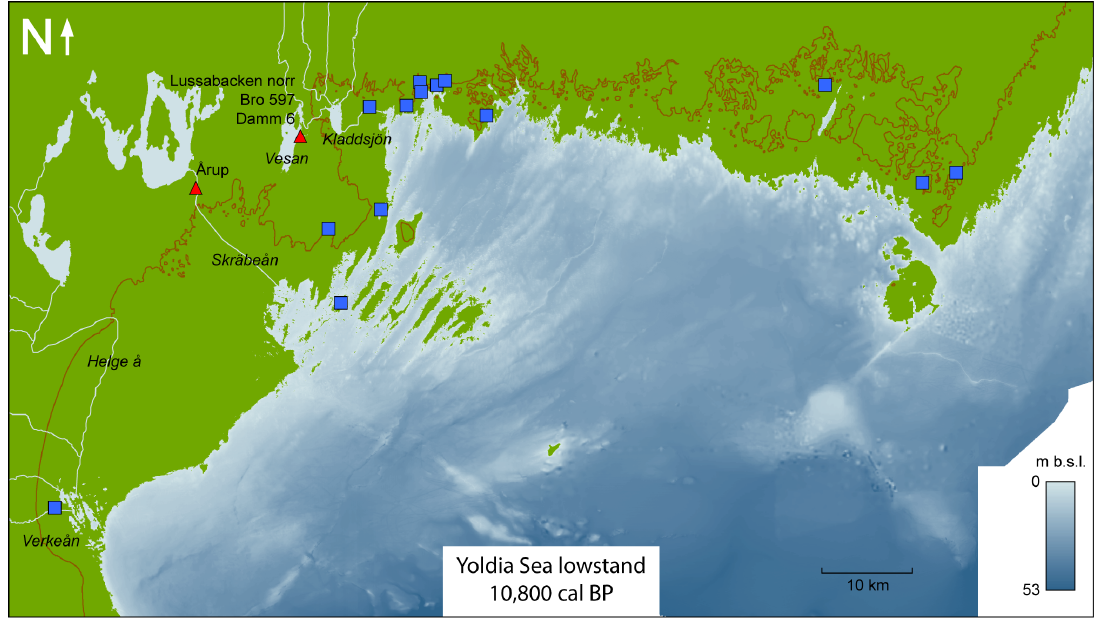
Figure 6. Paleo-shoreline reconstruction of the study area during the Yoldia Sea lowstand. The red line represents the present coastline. Red triangles represent archaeological sites discussed in the text. Blue squares represent areas where submerged wood remains have been reported. Light blue lines represent rivers discussed in the